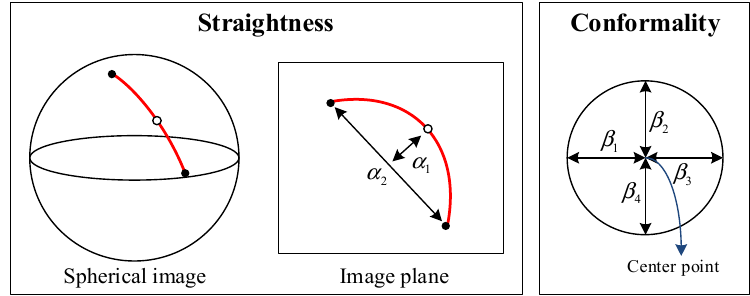
Figure 15. Straightness and conformality as the criteria in the quantitative evaluation. The maximum values of straightness and conformality are 1. As these values get closer to 1, the degradation in the straightness and conformality decreases. Figure 16 displays the patterns that occur using the various algorithms when nested squares are used as a test pattern to evaluate the straightness and conformality. It can be observed that some lines are curved and some red circles have been deformed. The bent lines imply that the applied methods result in poor performance with respect to the straightness. In a case where the circle is badly deformed, we know that the conformality of the algorithm is not